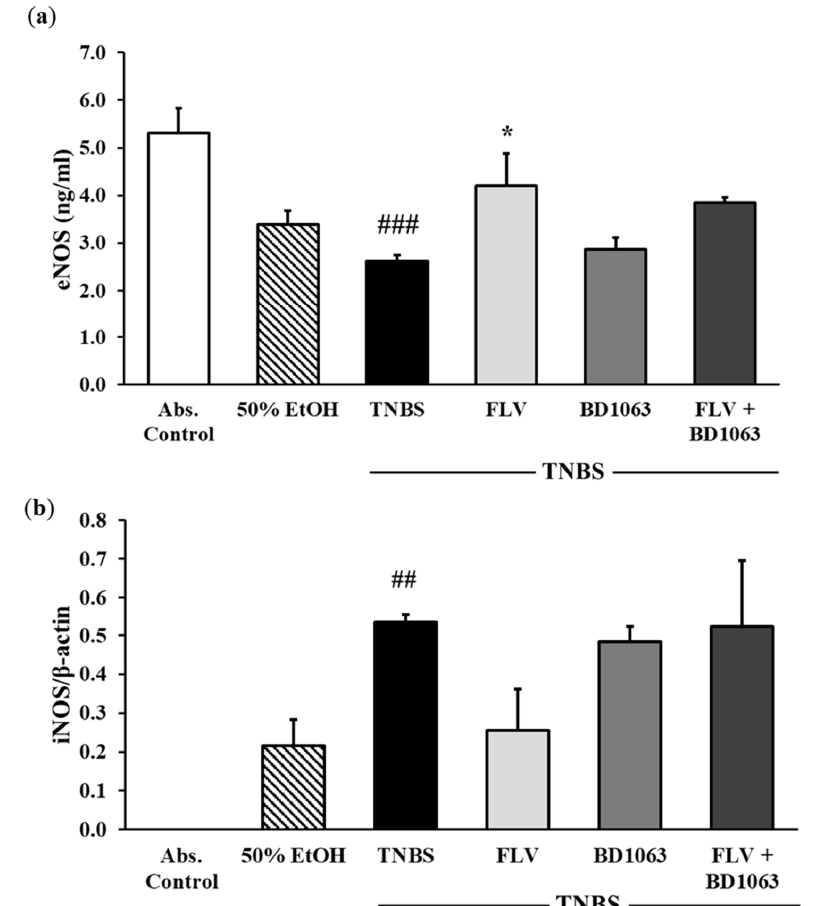
Figure 8. Effects of sigma-1 receptor ( σ 1R) agonist and antagonist on the levels of endothelial nitric oxide synthase (eNOS) ( a ) and expression of the inducible (iNOS) form ( b ). Abs. control (no treatment), 50% EtOH (50% ethanol enema), TNBS (2,4,6-trinitrobenzenesulfonic acid enema), FLV (TNBS enema + 1 mg / kg fluvoxamine (FLV)), BD1063 (TNBS enema + 0.1 mg / kg BD1063), FLV + BD1063 (TNBS enema + 1 mg / kg FLV + 0.1 mg / kg BD1063). Data are represented as mean ± SEM; ( n = 5–8); statistical significance ## p < 0.01 Abs. control vs. TNBS; ### p < 0.001 Abs. control vs. TNBS; * p < 0.05 TNBS vs. TNBS + treatment.